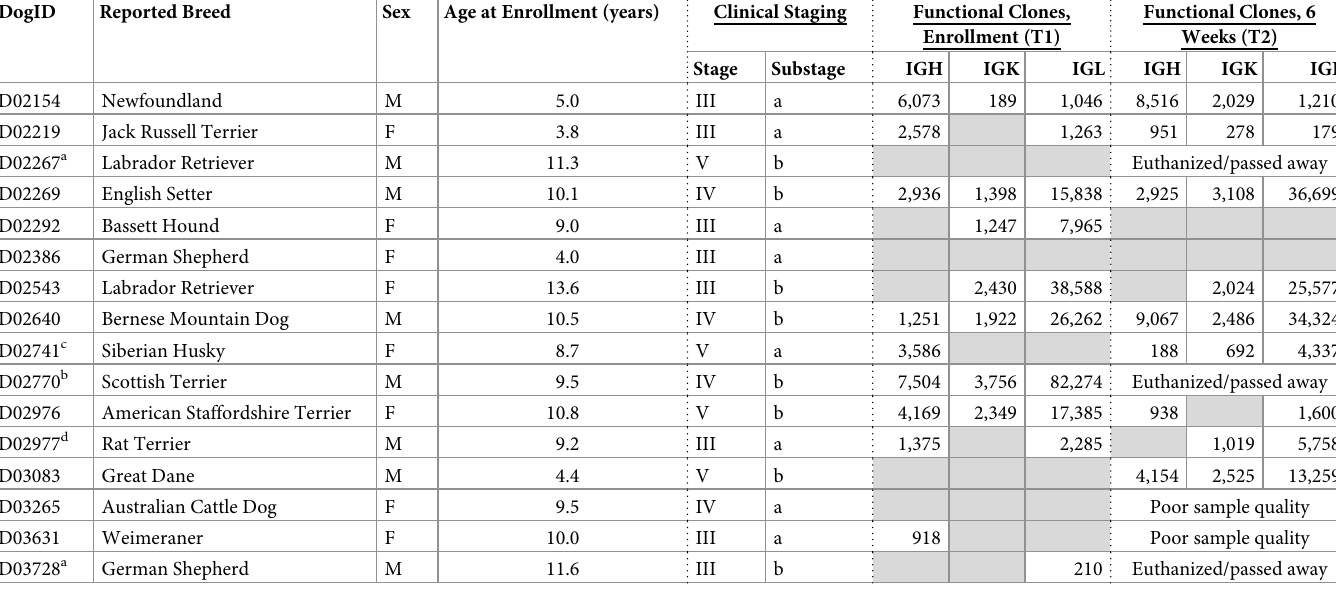
Table 1. Signalment and functional clone count of